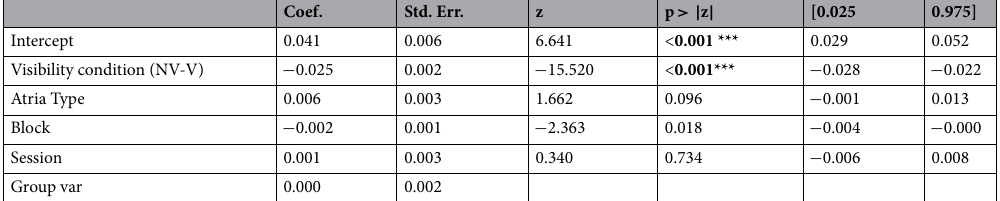
Table 2. Results of the ‘ Average Vertical Head Movement ’ Linear mixed effects model regression (LEMR), VerticalHeadMovement ∼ AtriaType + Block + VisibilityCondition + Session + ( 1 | Participant ) , we denote p-values satisfying the Bonferroni corrected alpha with ***.